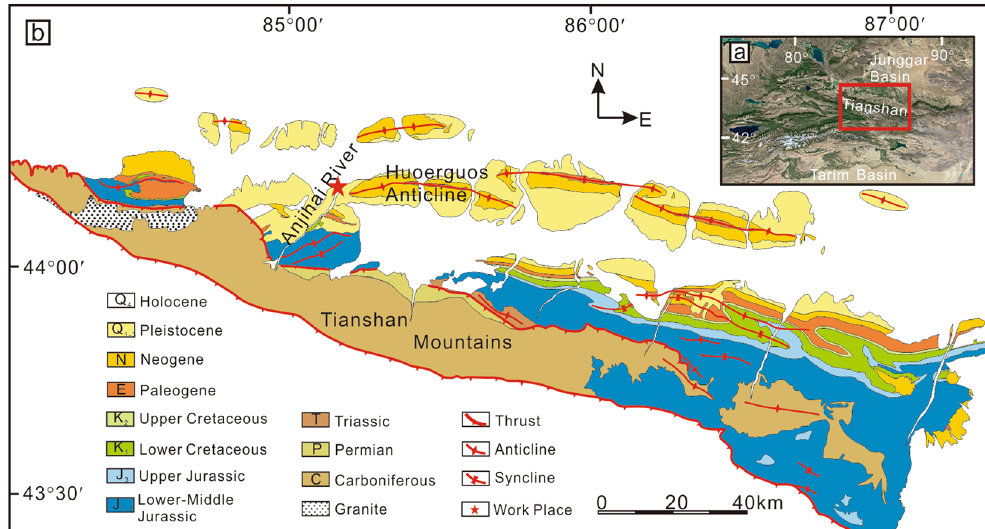
Figure 1. Geological background of northwest China. ( a ) The satellite image of northwest China, including the Junggar Basin, Tianshan Mountains, and Tarim Basin from Google Earth (map data: Google, Image Landsat/ Copernicus) ( b ) Geological map of the northern Chinese Tianshan Mountains and the southern Junggar Basin (modified from 26 ). The red star indicates the working area, also known as the Anjihaihe